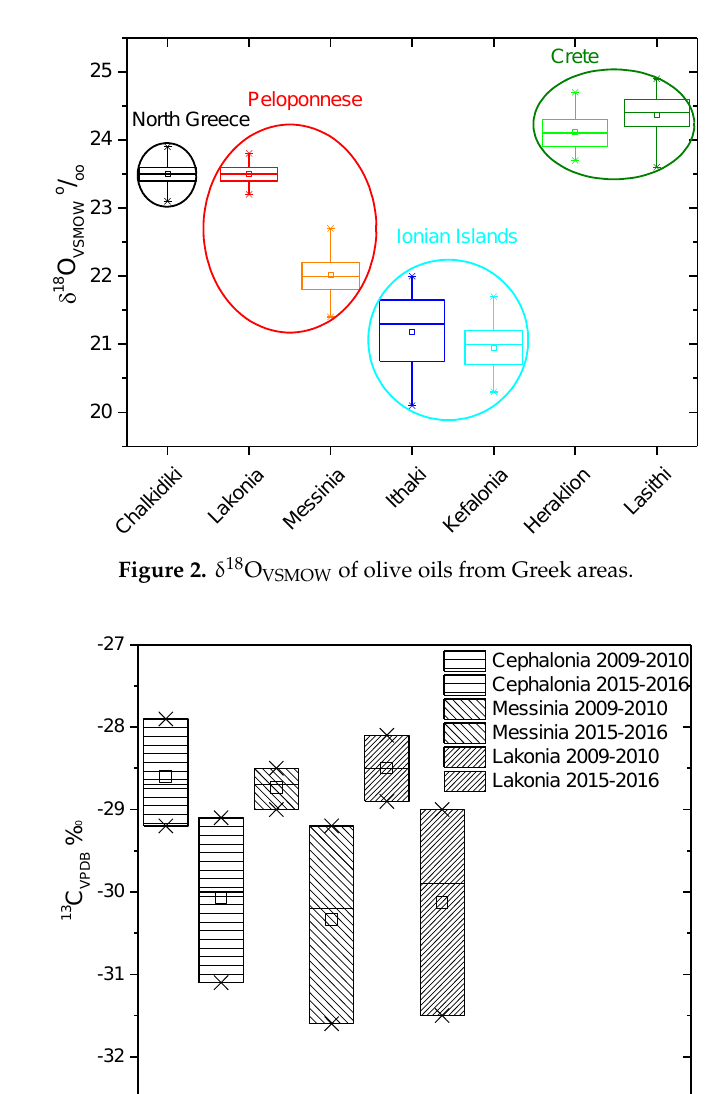
Figure 3. Comparison of δ 13 C VPDB values of olive oils from Cephalonia, Messinia, and Lakonia